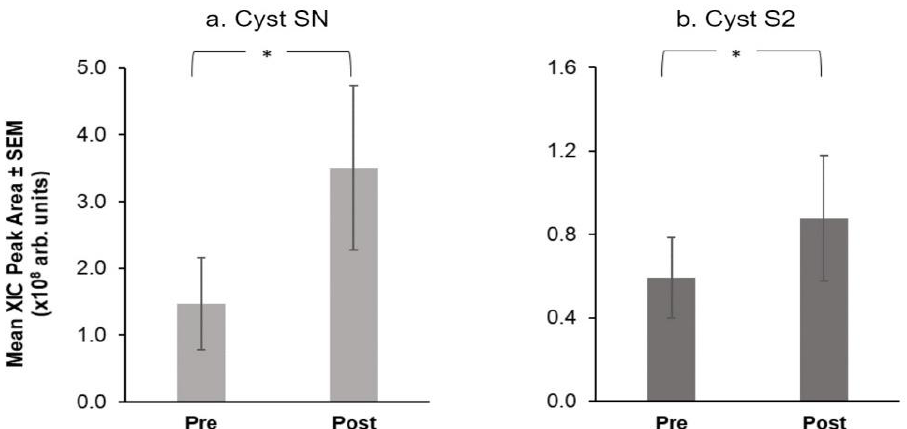
Figure 6. Mean extracted ion current (XIC) peak area ± SEM ( × 10 8 arbitrary units) of S-type Cystatins, ( a ) Cyst SN and ( b ) Cyst S2 before and after the CPE oral rinse intervention. * shows significant effect of treatment ( p < 0.05) based on Friedman’s ANOVAs ( n = 16).